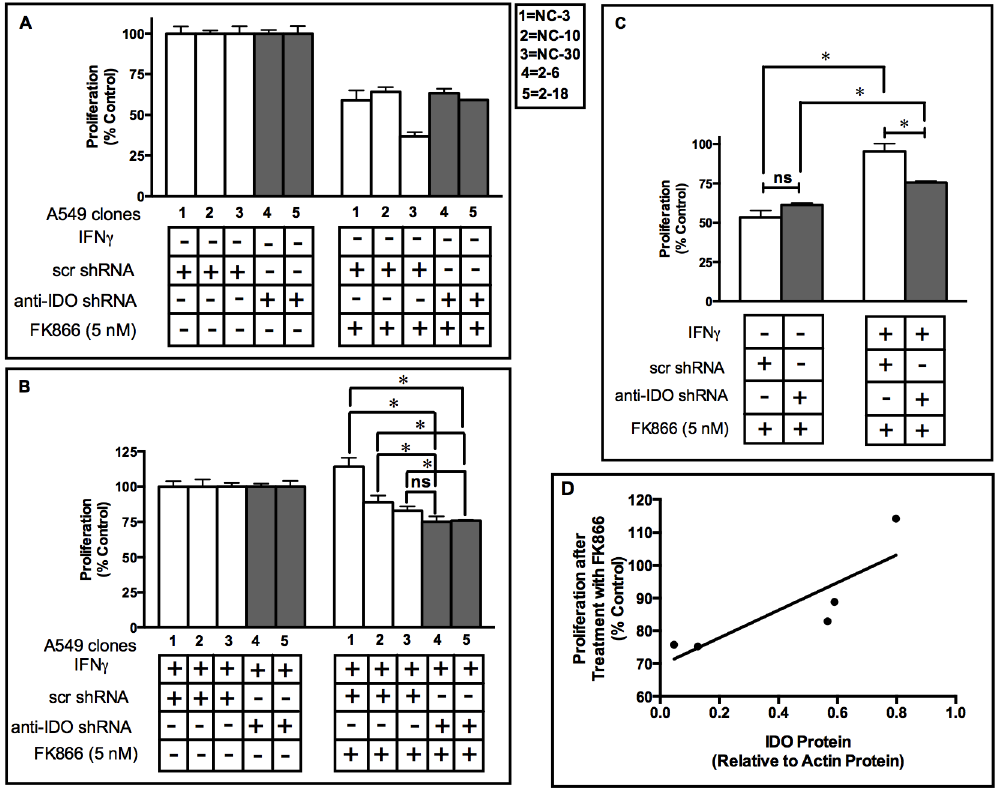
Fig 1. A549 clonal cell population sensitivity to FK866 (5 nM) before and after IDO induction. Proliferation of each of 5 individual A549 cell clonal populations before ( Panel A ) and after ( Panel B ) IDO induction with IFN γ . A549 clonal cell populations were cultured with or without IFN γ (25 ng/ml) for 48 h. Medium was then replaced with fresh growth medium containing FK866 (5 nM) and cells were allowed to proliferate for 72 h. Cells were then trypsinized and live cells were enumerated. White bars : A549 clones transfected with scrambled, non-targeting control shRNA. Gray bars : A549 cells transfected with anti- IDO shRNA. Results are normalized to control cells not treated with FK866, without (panel A) or with (panel B) IFN γ treatment. Each bar represents the mean of 3 values ( n = 3) ± SD, ( * , p (cid:5) 0.05). Panel C : A549 clonal resistance to FK866 before and after IFN γ -mediated IDO induction. Pooled results were obtained from 3 or 2 independent A549 clonal populations stably transfected with scrambled shRNA (white bars) or 2 anti-IDO shRNA (black bars) respectively, before and after induction of IDO. Each bar represents a mean of 9 (white bars) or 6 (black bars) values ± SEM, Significant difference, Student's t -test, p < 0.05. Panel D : Correlation analysis of the relationship between IDO protein content (relative to actin) and clonal population resistance to FK866 (proliferation relative to untreated control cells).